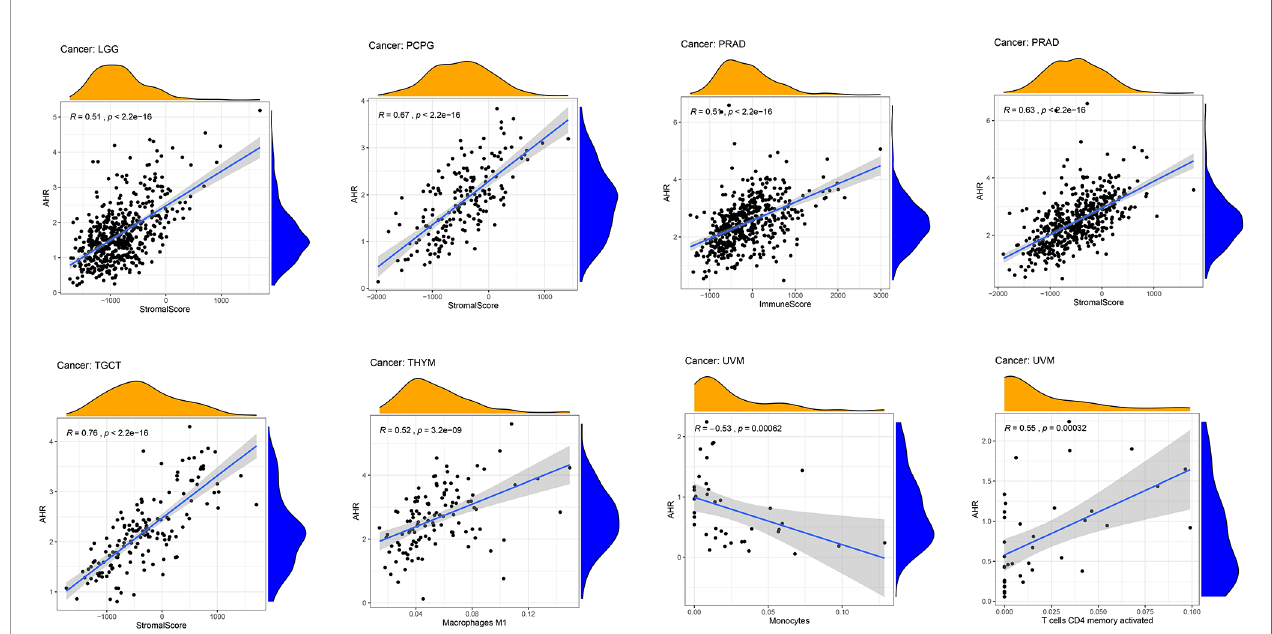
FIGURE 5 | The correlation between AhR expression and both the ESTIMATE score and immune cell in fi ltration. The ESTIMATE score includes stromal score (indicates the presence of stromal cells in tumor tissues), immune score (represents the in fi ltration of immune cells in tumor tissues), and tumor purity. The immune cell in fi ltration was calculated by CIBERSORT algorithm. The correlation plots were illustrated if R > 0.5 and p < 0.05.